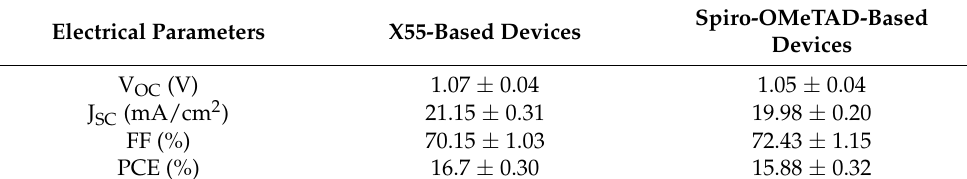
Table 1. Statistics of the fabricated small area cells: 16 with X55 HTM and 16 with Spiro-OMeTAD HTM. Electrical Parameters